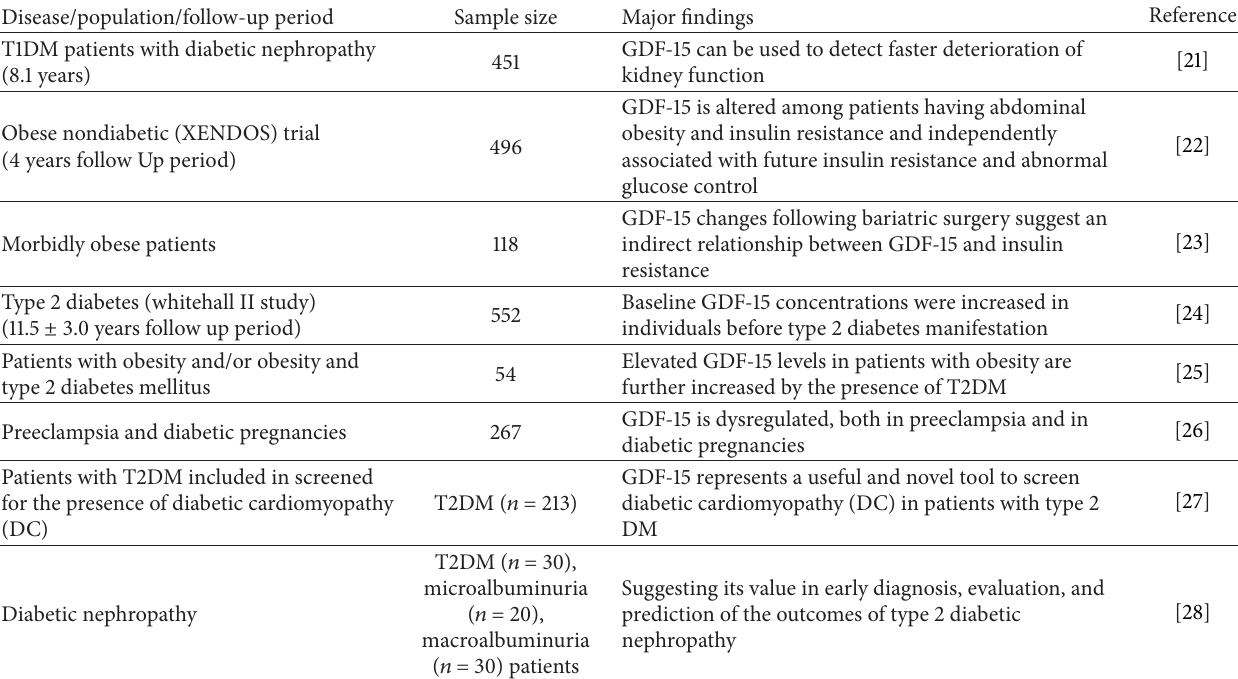
Table 1: List of human studies dealing with GDF-15 levels in obesity and